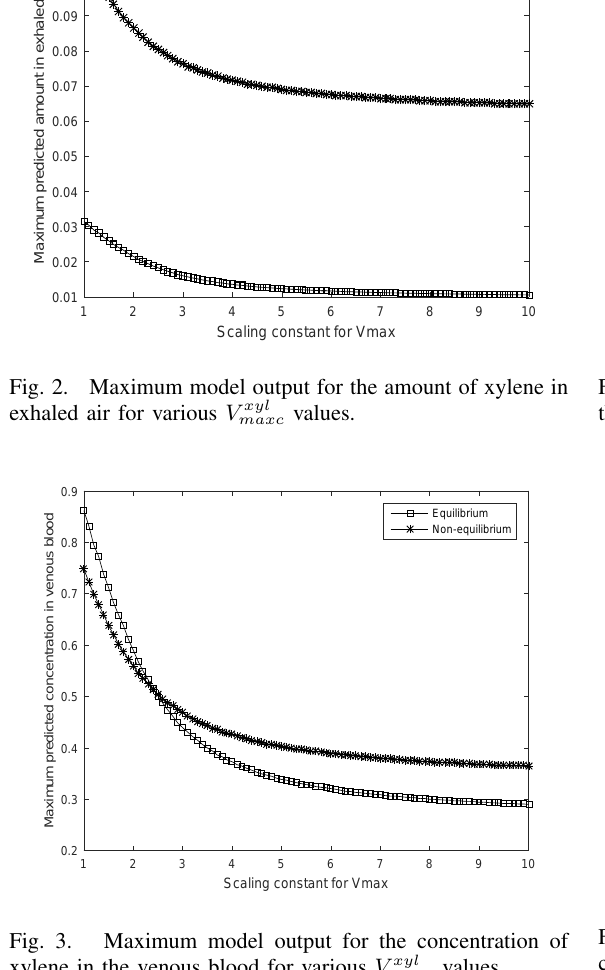
Fig. 3. Maximum model output for the concentration of xylene in the venous blood for various V xyl maxc values.